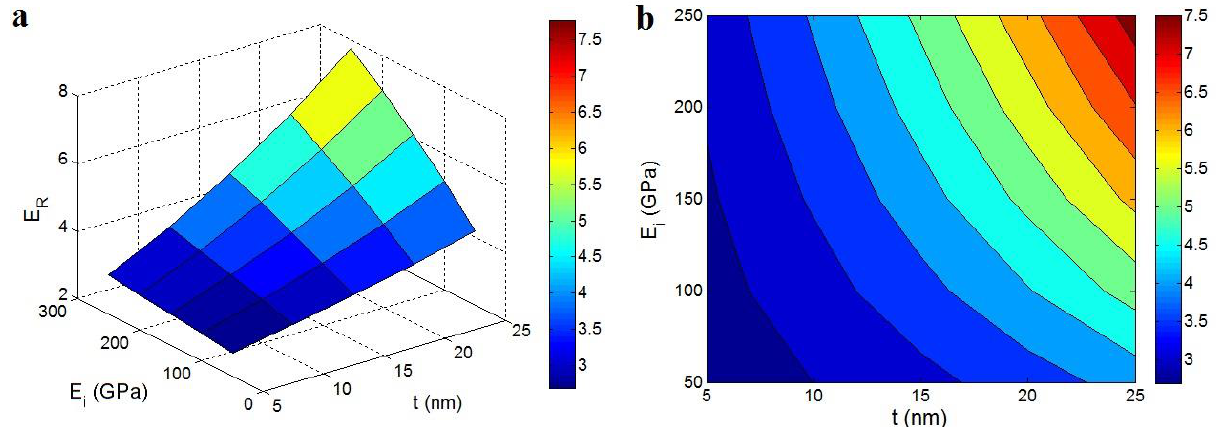
Figure 4. Relative modulus assuming interphase factors according to the advanced model at E m = 2 GPa, ϕ f = 0.02, E f = 1000 GPa, l = 5 µ m and R = 10 nm: ( a ) 3D and ( b ) contour plans.